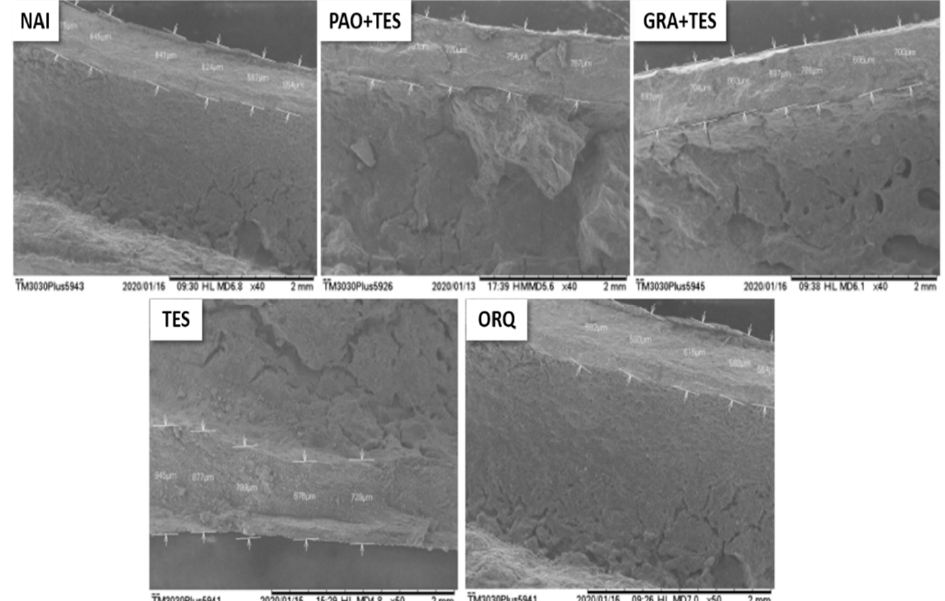
Figure 6. Representative scanning electron microscopy (SEM) of longitudinal sections of the femur body. No statistical divergences were observed among groups. All the pictures were taken from the same area (in 2 mm scaled) across the groups to ensure uniformity of the results. NAI: control naïve group; PAO + TES: orchiectomized group treated with purified annatto oil (200 mg/kg, p.o.) + testosterone (7 mg/kg, IM); GRA + TES: orchiectomized group treated with PAO granules (200 mg/kg, p.o., Chronic ® ) + testosterone (7 mg/kg, IM); TES: orchiectomized group treated only with testosterone (7 mg/kg, IM); ORQ: orchiectomized group treated only with water.